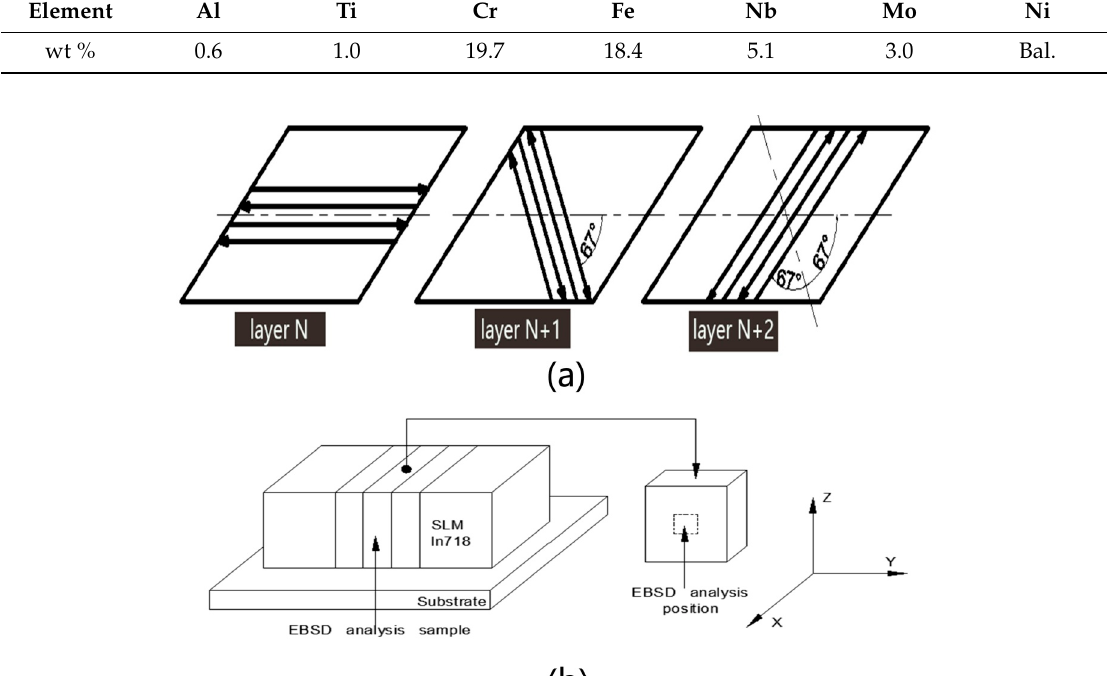
Table 1. Chemical composition of Inconel 718 (IN718) powder (mass fraction: %).